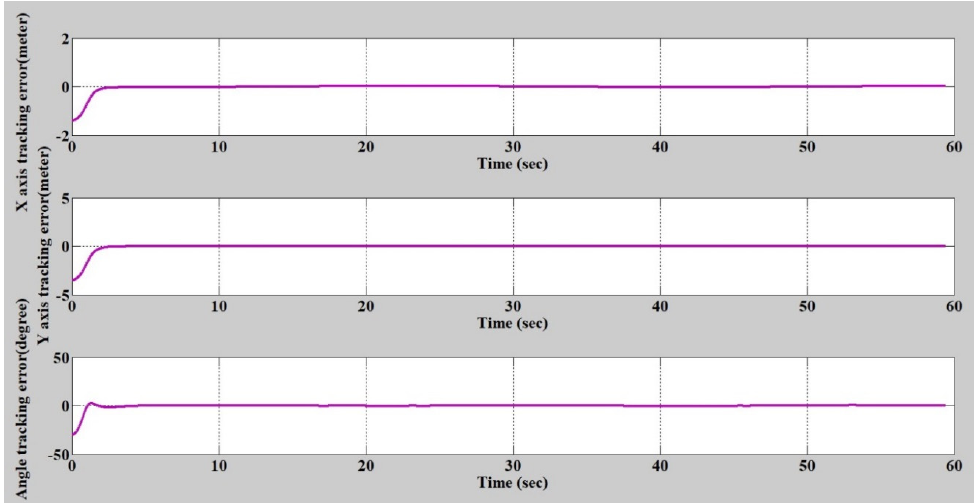
Figure 6. Results of circular trajectory tracking errors concerning initial point ( x c = 0 m, y c = − 1.9 m).